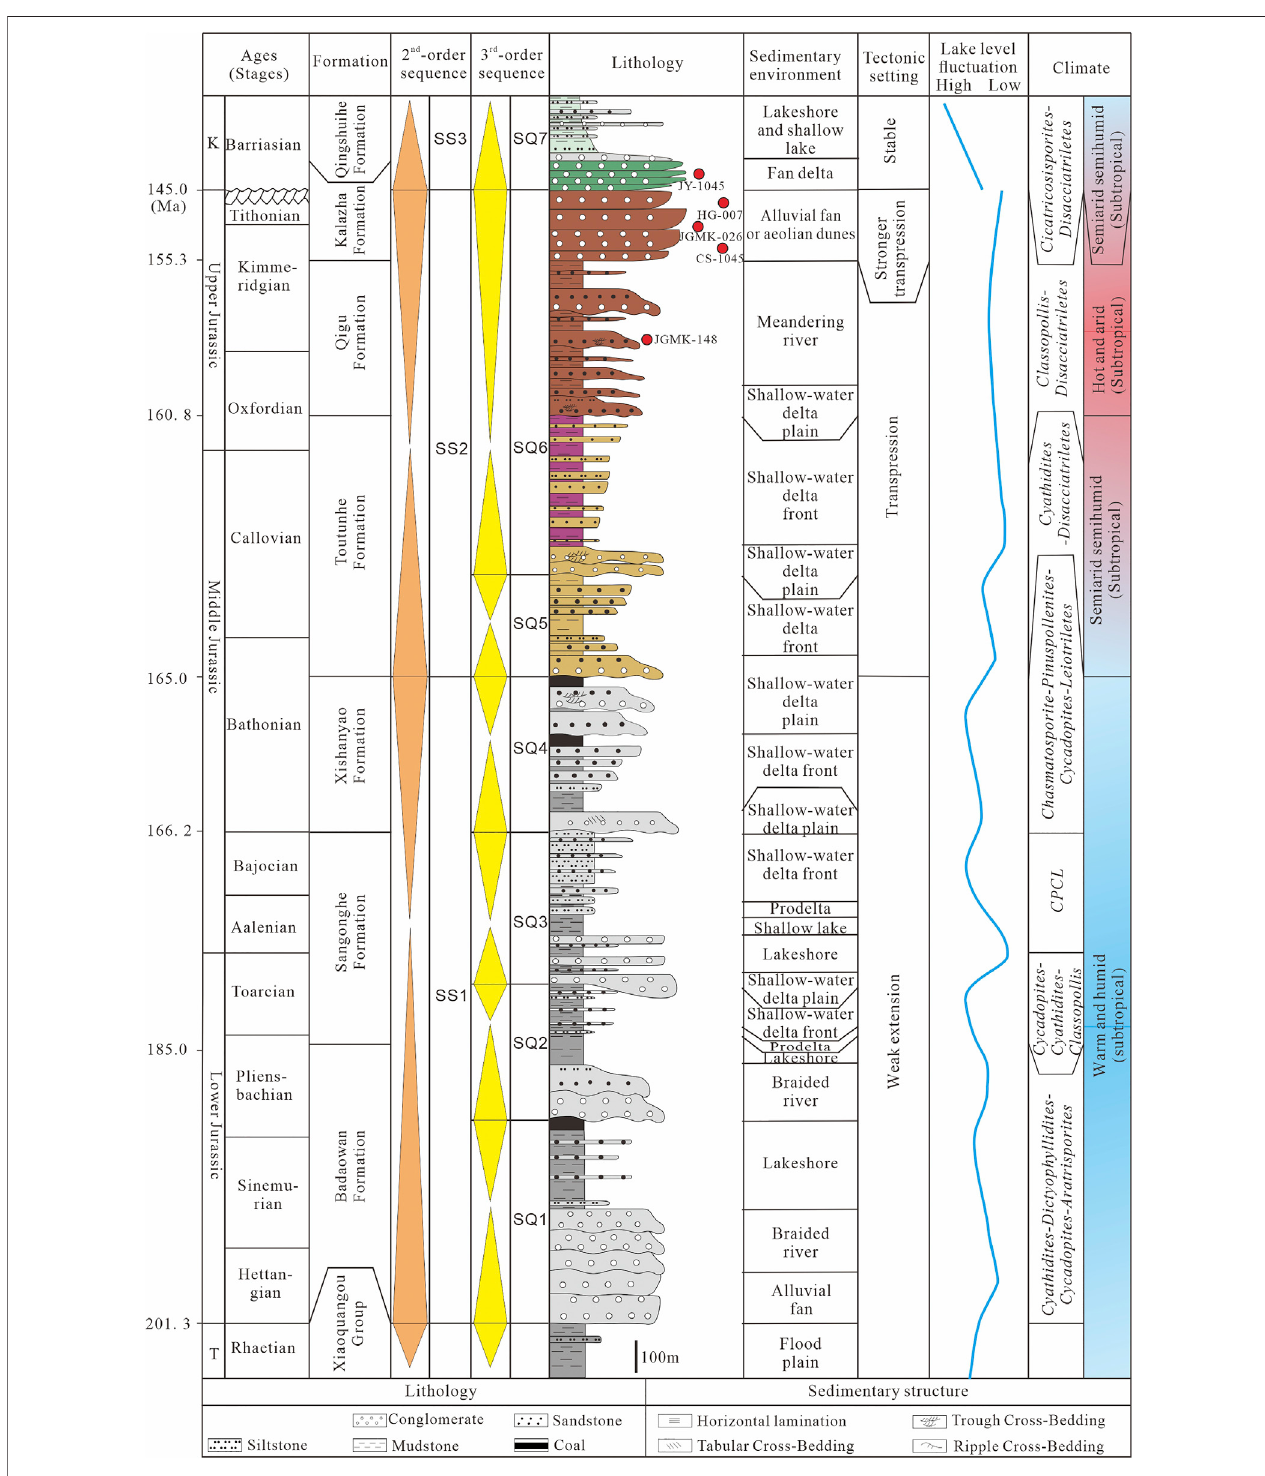
FIGURE 2 | Comprehensive stratigraphic column of the Southern Junggar Basin. T-Triassic; K-Cretaceous; CPCL-Chasmatosporite-Pinuspollenites- Cycadopites-Leiotriletes.AgesarefromDengetal.(2015)andHuang(2019).Thespore-pollenassemblageandclimatedataarefromDengetal.(2015)andTian(2017).